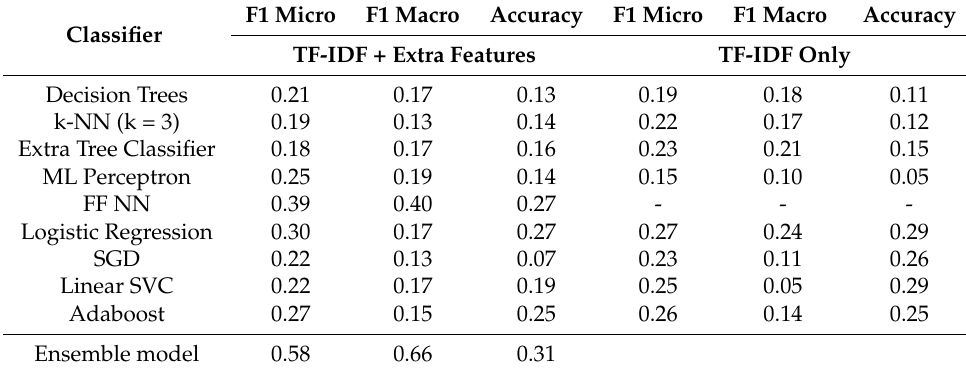
Table 14. Comparison of the ensemble model with other machine learning (ML)